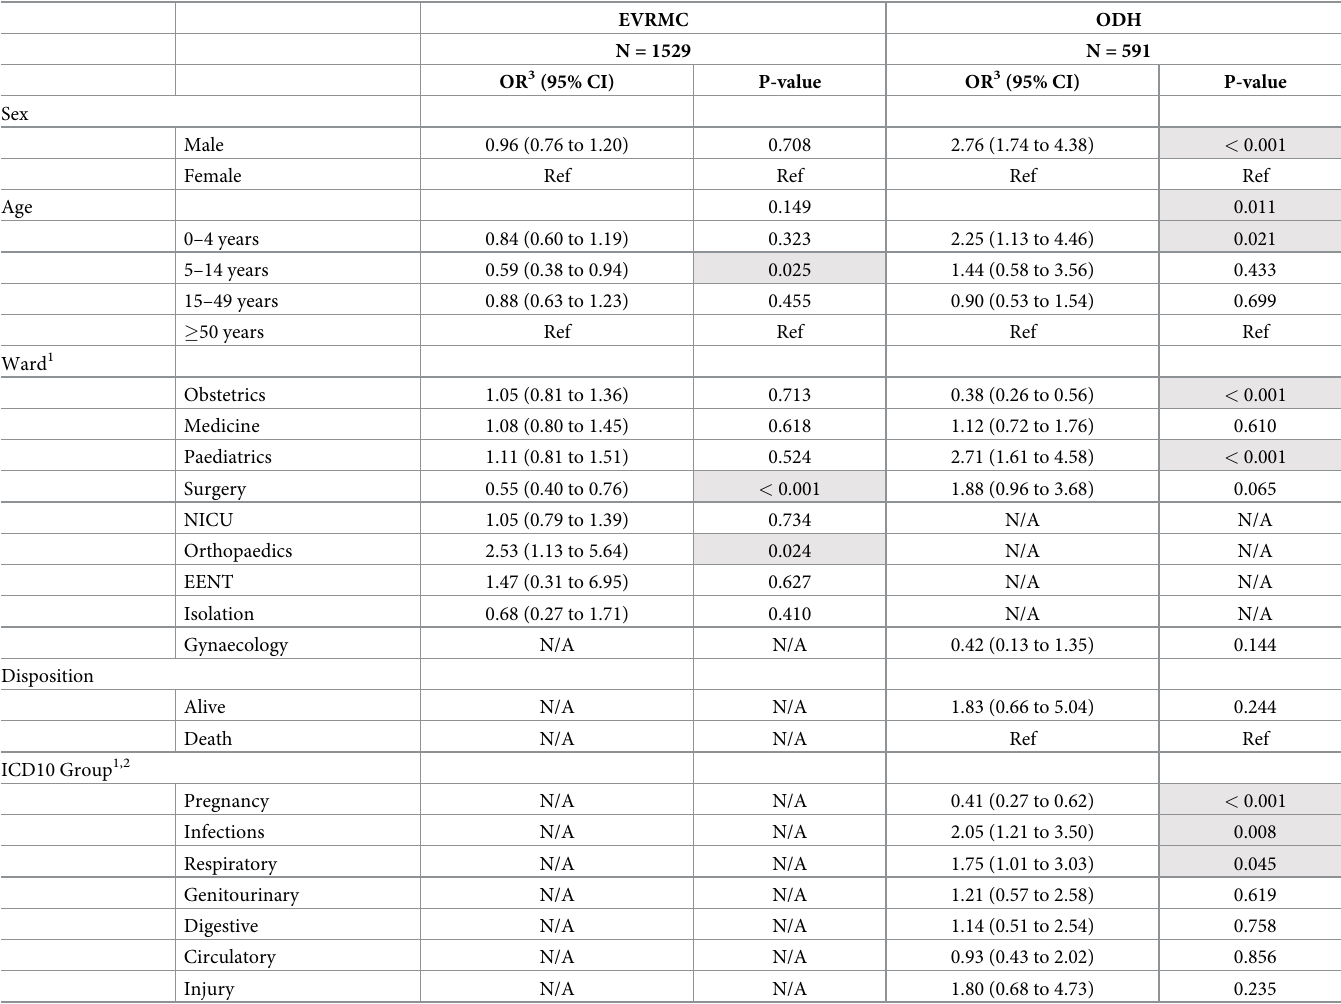
Table 3. Measures of association for different characteristics, comparing admissions before (November 1–7) and after (November 8–30)